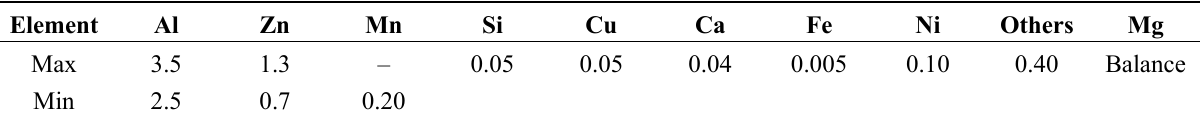
Table 1. Nominal chemical composition of Magnesium alloy